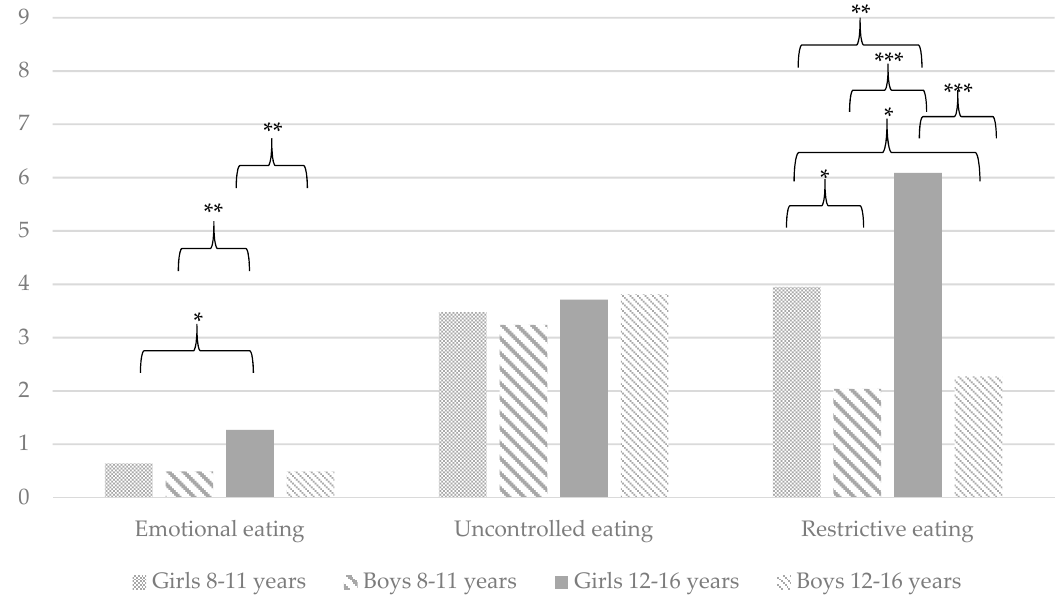
Figure 1. A child’s perspective: Mean problematic eating behaviours measured by the Three-Factor Eating Questionnaire (TFEQ-R13). * p < 0.05, ** p < 0.01, *** p < 0.001. Only statistically significant differences are marked on the graph.